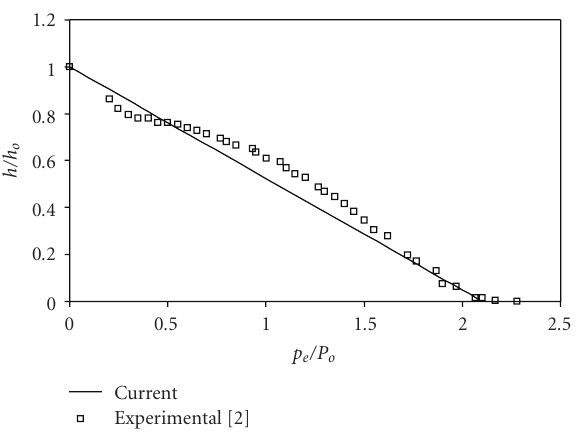
Figure 4: Pressure versus deflection curve for elastic wall. (Deflection is measured as lowest point on the symmetric plane. Normalization constants P o = 1000Pa and h o = 1 .